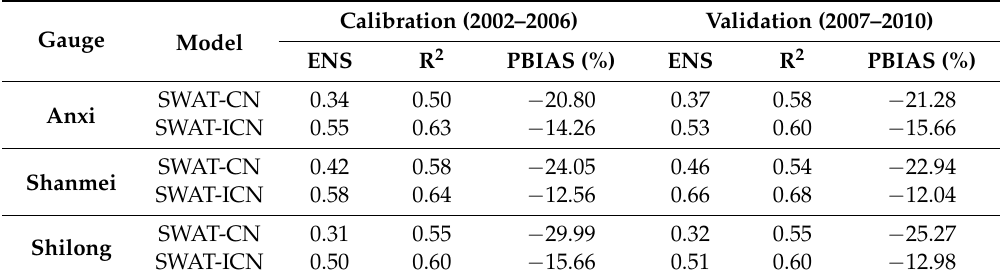
Table 5. Performance measures of SWAT-ICN and SWAT-CN in simulating base flow in Anxi, Shanmei, and Shilong subbasins for calibration and validation